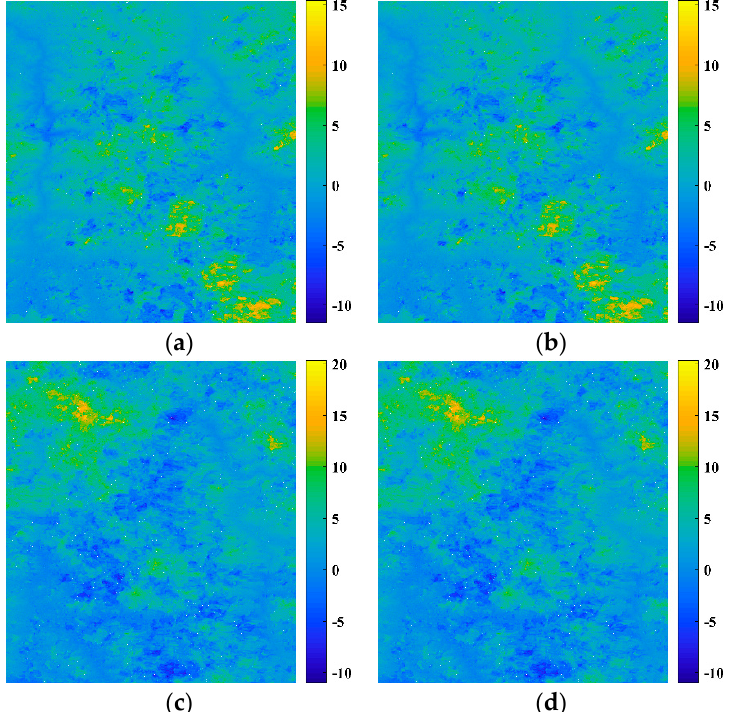
Figure 8. DInSAR LOS displacement in the VV and VH polarization; for 11 February 2019 ( a , b ), for 19 March 2019 ( c , d ), respectively, derived using the approach mentioned in Section 3.2.